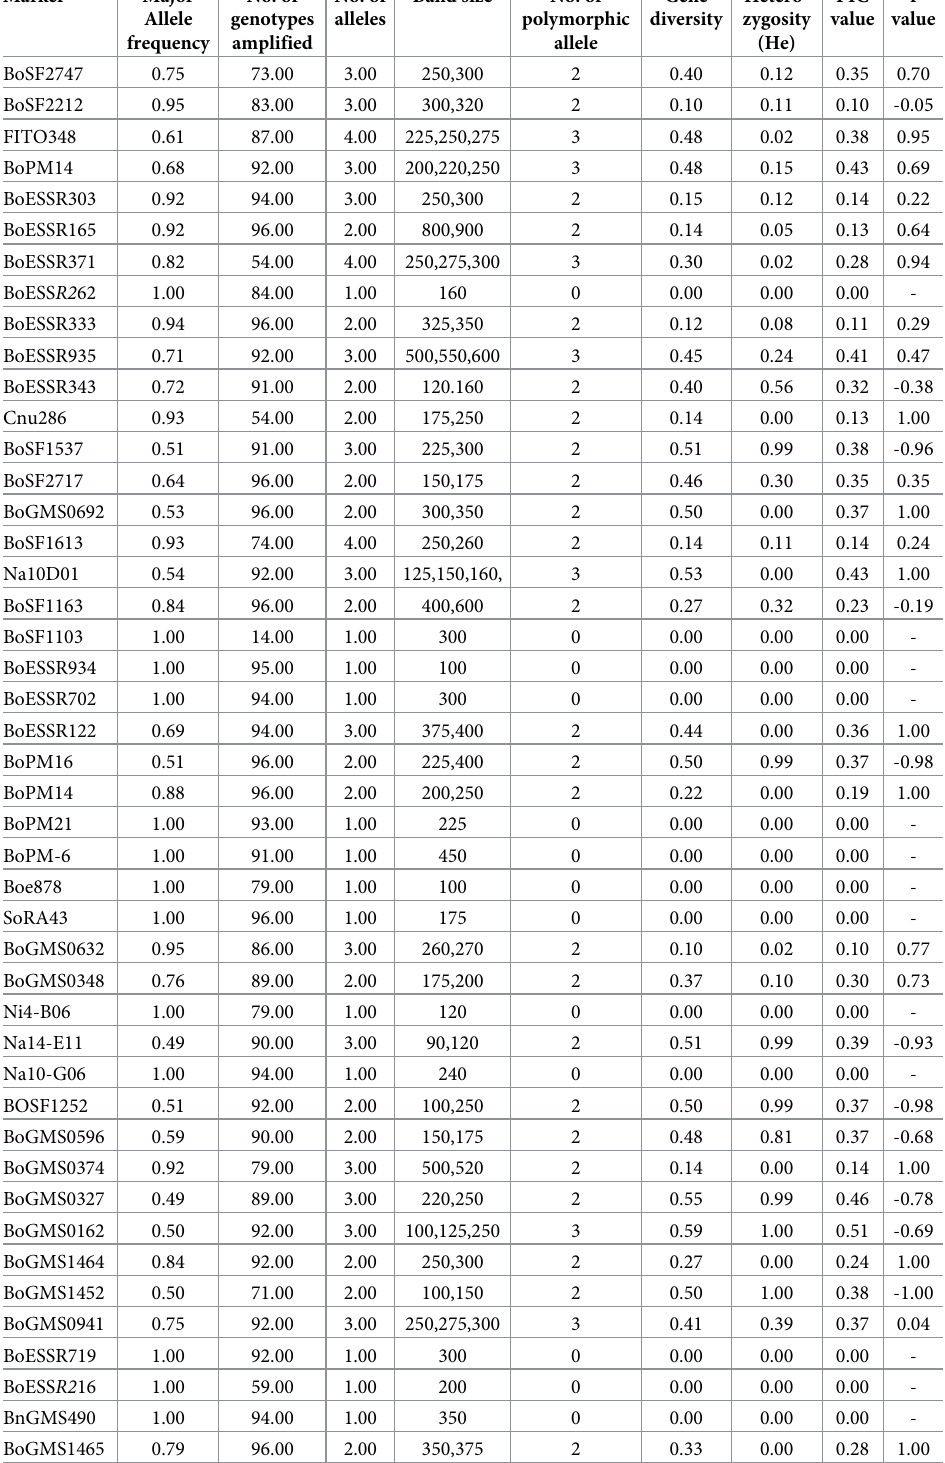
Table 3. SSR Loci, major allele frequency, gene diversity, heterozygosity value (He), number of alleles andPIC value in the cauliflower